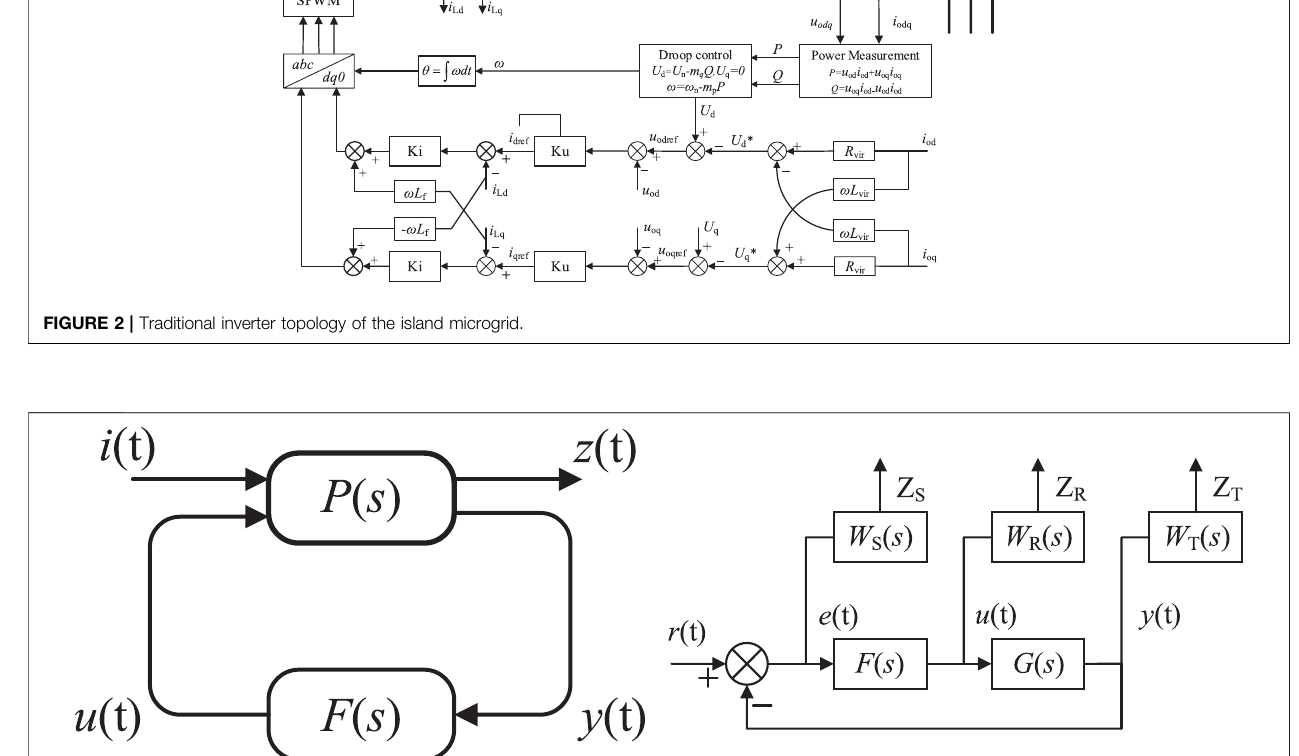
Frontiers in Energy Research |